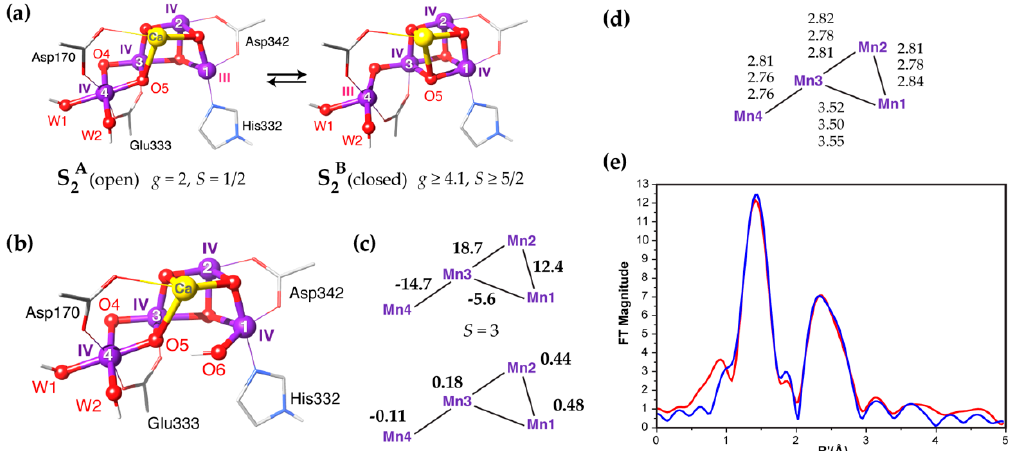
Figure 4. ( a ) Computational structural models for the inorganic core of the S 2 state of the OEC; ( b ) oxo–hydroxo model for the S 3 state, bearing an OH − ligand to Mn1; ( c ) computed exchange coupling constants (top, in cm − 1 ) leading to a total spin S = 3 ground state for the oxo–hydroxo S 3 state model, and corresponding manganese spin projection coefficients (bottom) [68]; ( d ) computed Mn–Mn distances reported for the oxo–hydroxo S 3 state model by three different groups (top: Krewald et al. [30]; middle: Askerka et al. [97]; bottom: Li et al. [98]); ( e ) and simulated EXAFS spectrum (blue) for the oxo–hydroxo computational model of the S 3 state compared with the experimental spectrum (red), from Li et al. [98].